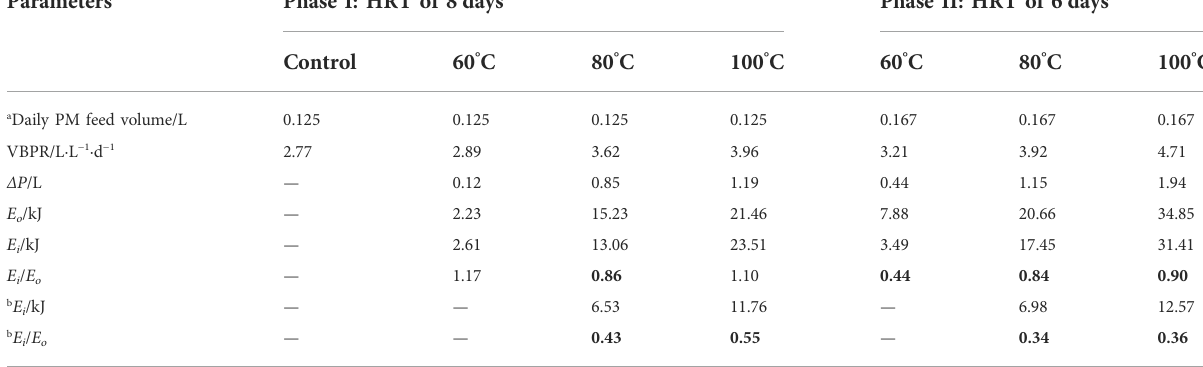
TABLE 4 Energy expenditure and income of an assumed semi-continuous AD process.